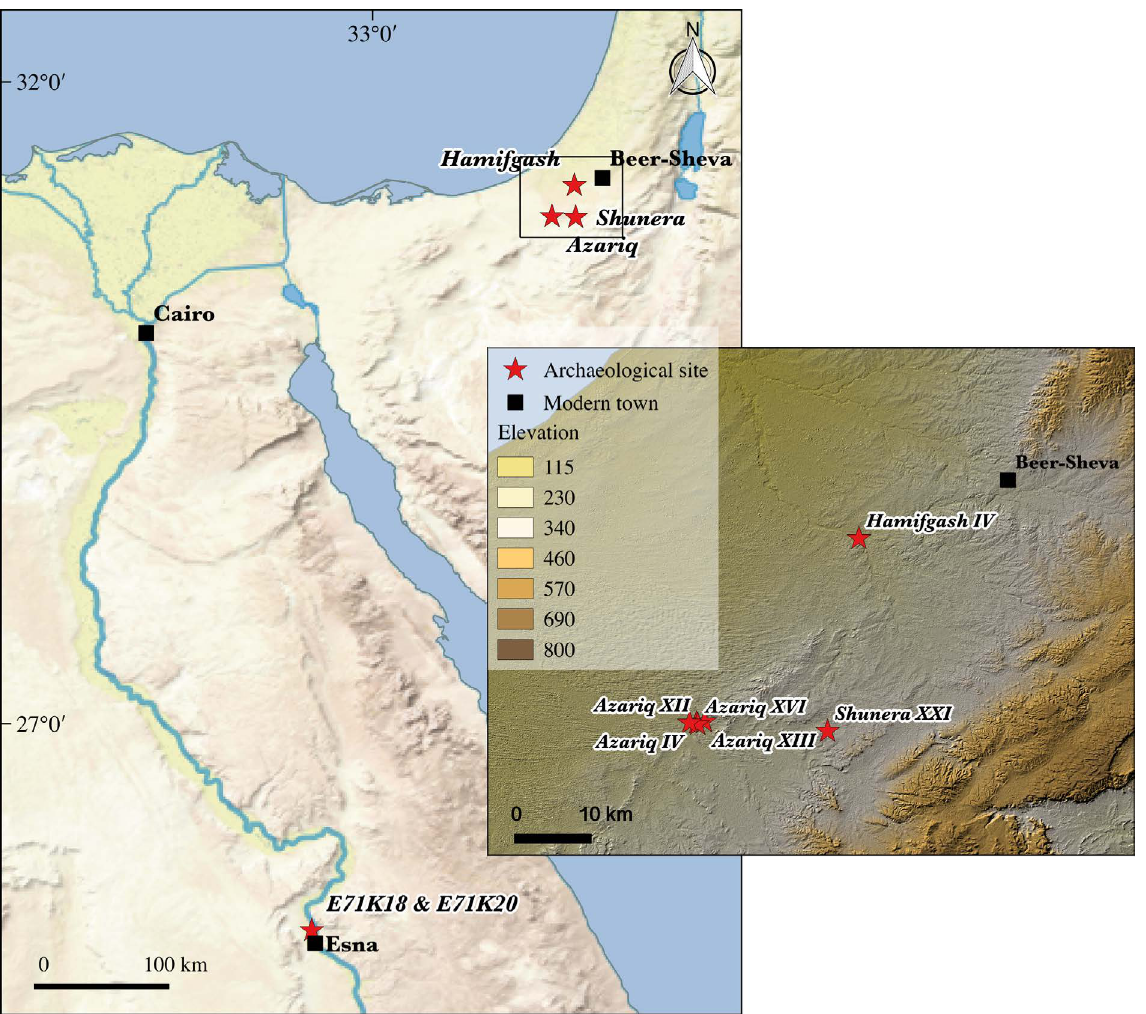
Figure 1. Location of sites mentioned in the text. Elevation map after SRTM 1 Arc-second Global elevation data available from the U.S. Geological Survey. Base map made using Natural Earth Data. Both made with